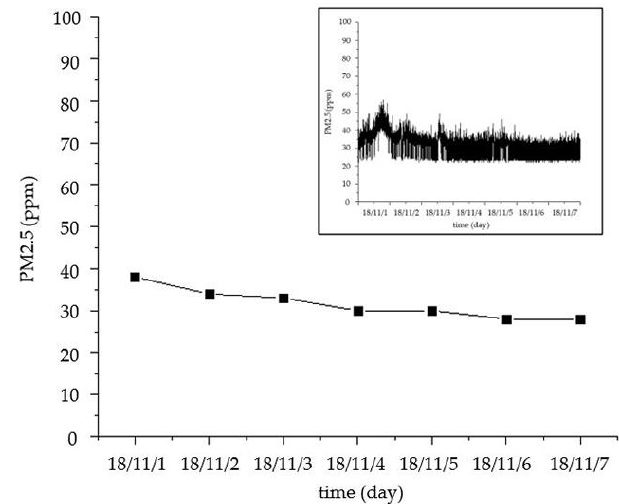
Figure 29. The curve of PM2.5 concentration in a week.